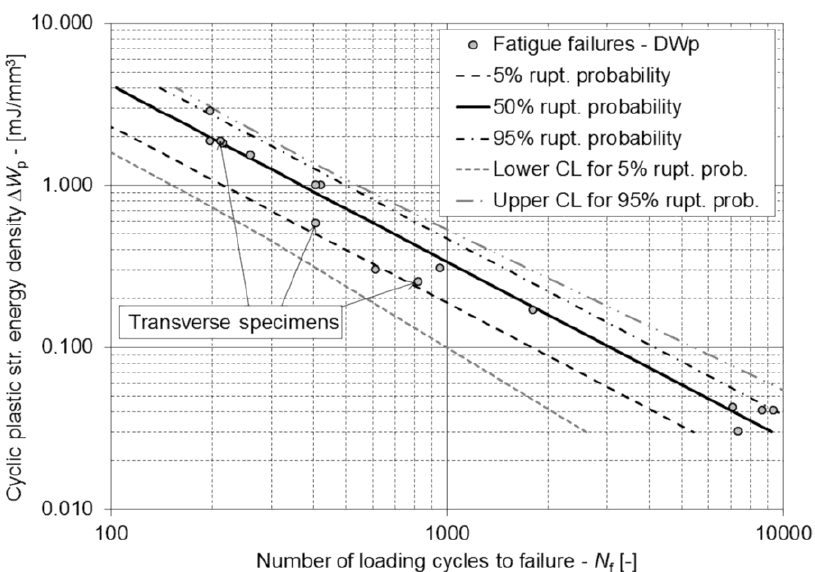
Figure 7. AZ31 fatigue-life curves for the plastic strain-energy density ∆ W p .